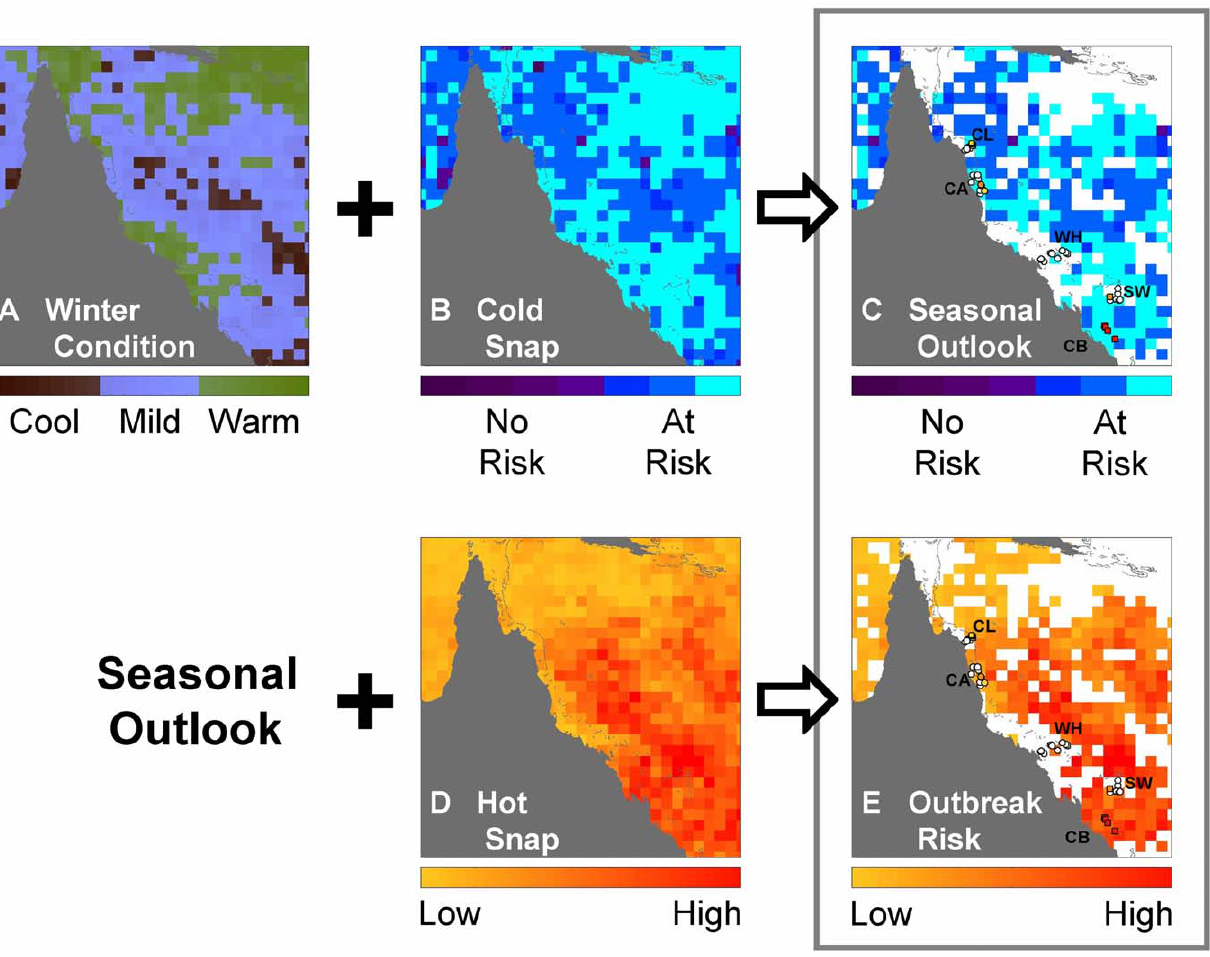
Figure 6. Maps of metrics and risk assessments for 2001-02. (a) Winter Condition for winter 2001; (b) Cold Snap for winter 2001; (c) Seasonal Outlook – Cold Snap spatially filtered by preceding mild-Winter Condition, overlaid with survey data [circle: Acropora cover , 30%, square: Acropora cover $ 30%; white: disease , 50 counts, yellow: 50 # disease , 100 counts, orange: 100 # disease , 200 counts, red: disease $ 200 counts]. Survey sectors indicated per Fig. 1; (d) Hot Snap for summer 2001-02; (e) Near real-time Outbreak Risk – Hot Snap spatially filtered by preceding mild-Winter Condition and/or Cold Snap event, overlaid with survey data [as for (c)]. The grey box encloses the final risk assessment products.